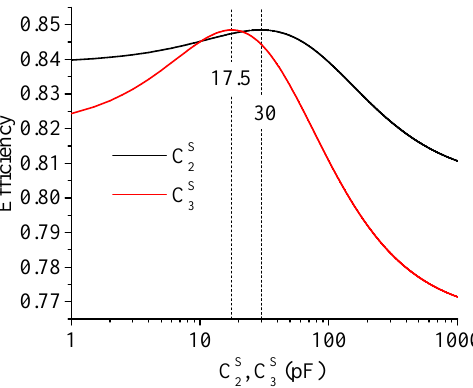
Figure 7. The simulated efficiency η as a function of the compensating susceptance C S C S (black curve) or C S (red curve) is varied, while keeping the other system parameters at their 2 3 optimal